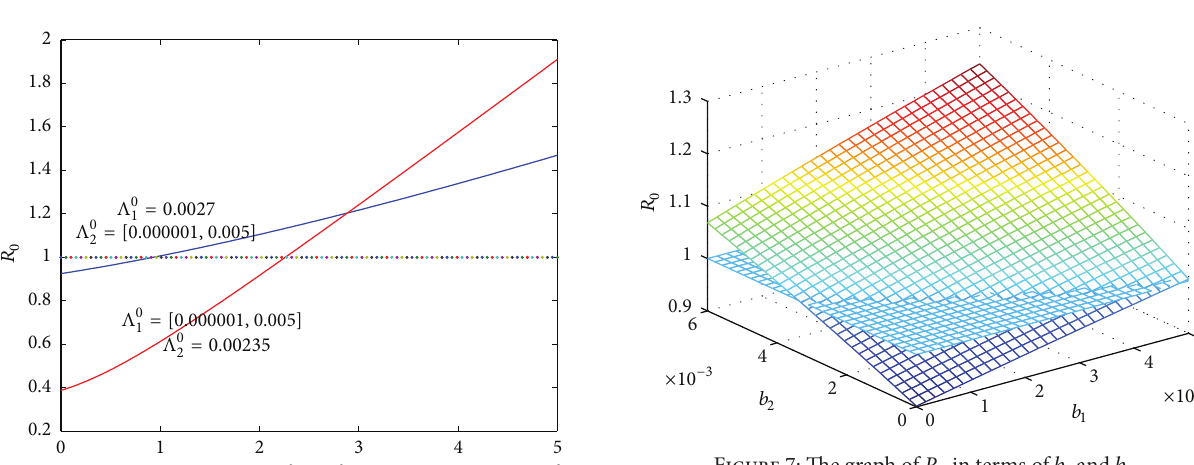
Figure 7: The graph of 𝑅 0 in terms of 𝑏 1 and 𝑏 2